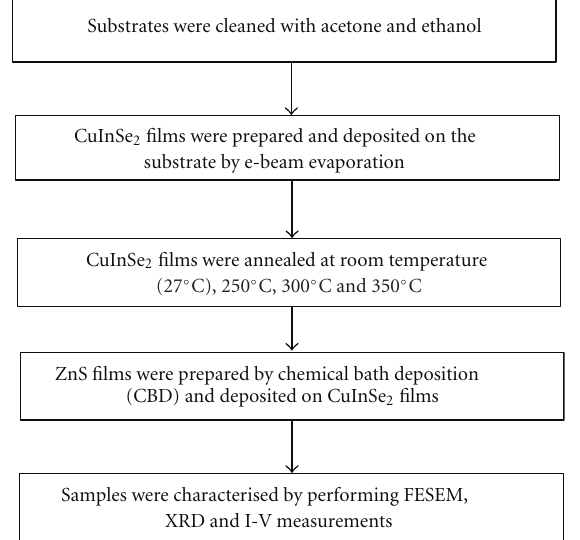
Figure 1: Flow chart of overall process in fabrication of CuInSe 2 :ZnS solar cell by electron beam evaporation and chemical bath deposition (CBD) method.